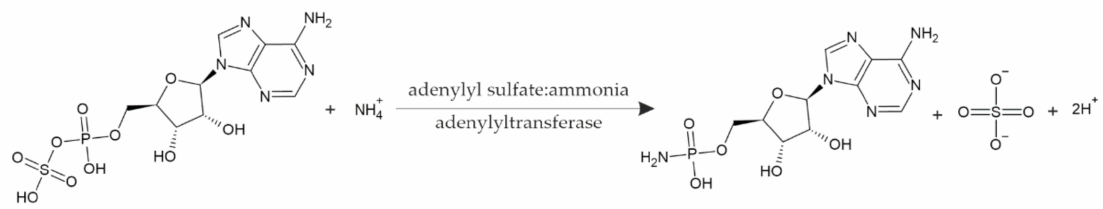
Figure 1. Scheme of the reaction catalyzed by adenylyl sulfate:ammonia adenylyltransferase (EC